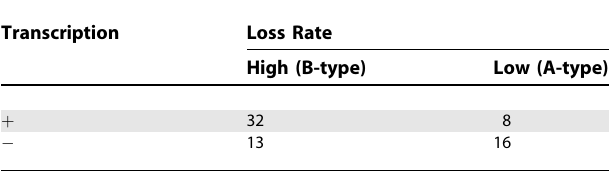
Table 4. Characterization of Unstable Plasmids Containing B- type ARSs Plasmid ARS Strain